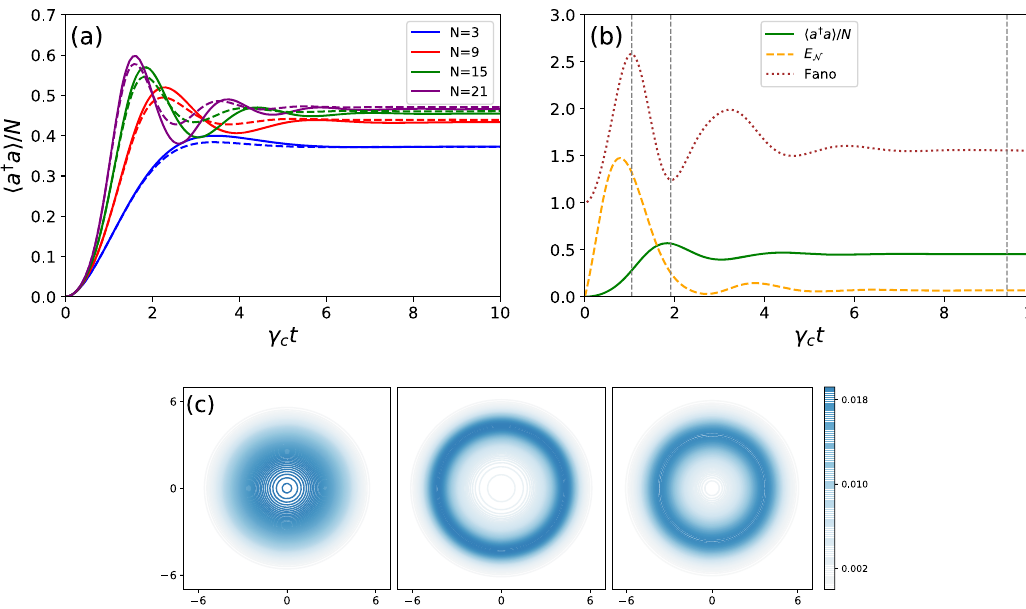
Fig. 2 Dynamics of the model. a Evolution of the scaled cavity average photon number: 〈 a † a 〉 / N ; solid lines are the numerical solutions and dashed lines are the cumulant expansion approximation. b Evolution of 〈 a † a 〉 / N (green solid line), Fano factor (purple dotted line), as well as the entanglement (logarithmic negativity E N – orange dashed line) for the N = 15 case. c Wigner function snapshots at approximate time instants indicated by vertical dashed lines appearing in Fig. 2b. The parameters are γ c = γ d = 0.02 and λ = 0.01 (in units ω c = 1), corresponding to N crit =